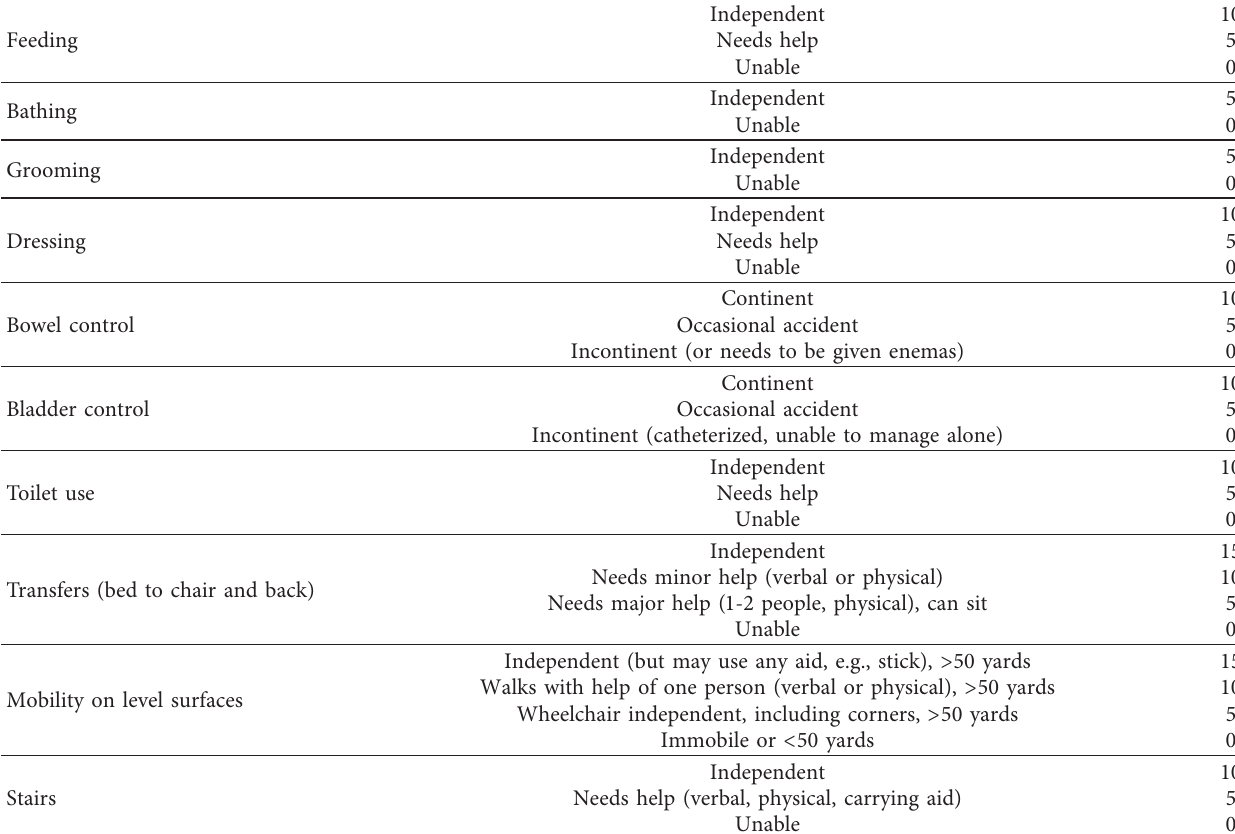
Table 2: Barthel index: rank the patient’s independence in the following areas.